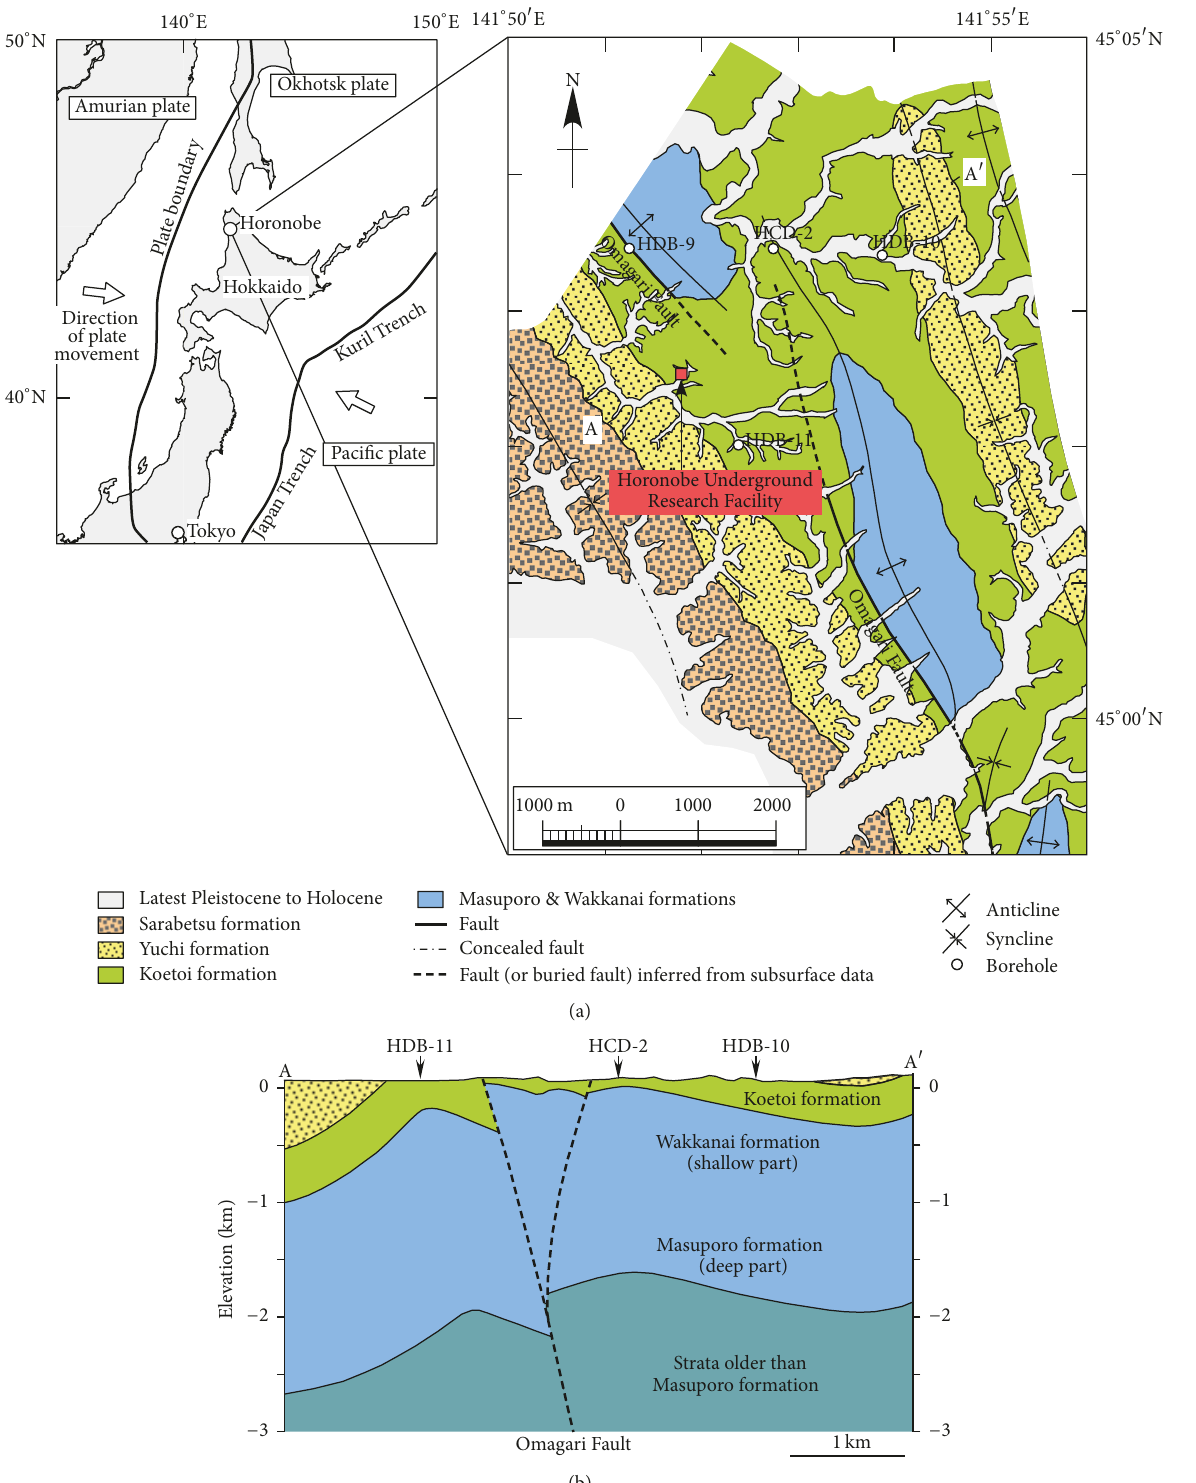
Figure 1: Maps and cross-sections showing the location of the Horonobe underground research facility and the boreholes (after [27, 40]): (a) location and geological maps and (b) geological cross section of the Horonobe area. The plate boundaries and the direction of plate movement are from Wei and Seno